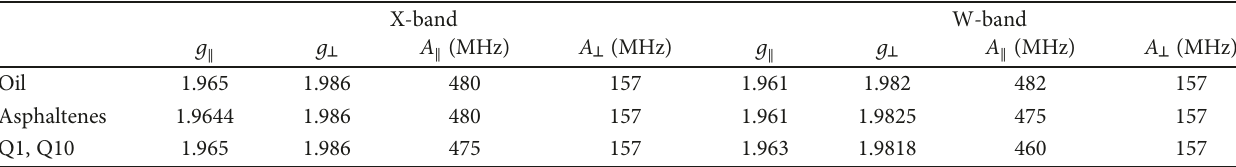
Figure 3: Schematic representation of a single vanadyl porphyrin molecule. The directions of the external magnetic fi elds “ in-plane ” ( B “ out-of-plane ” ( B ) for the W-band ENDOR measurements are shown (see Figures 4 and 5). 1 Table 2: EPR parameters for vanadyls derived from the MATLAB EasySpin approximations [59] of EPR spectra for two frequency ranges. Details of approximations are given in [49-52].